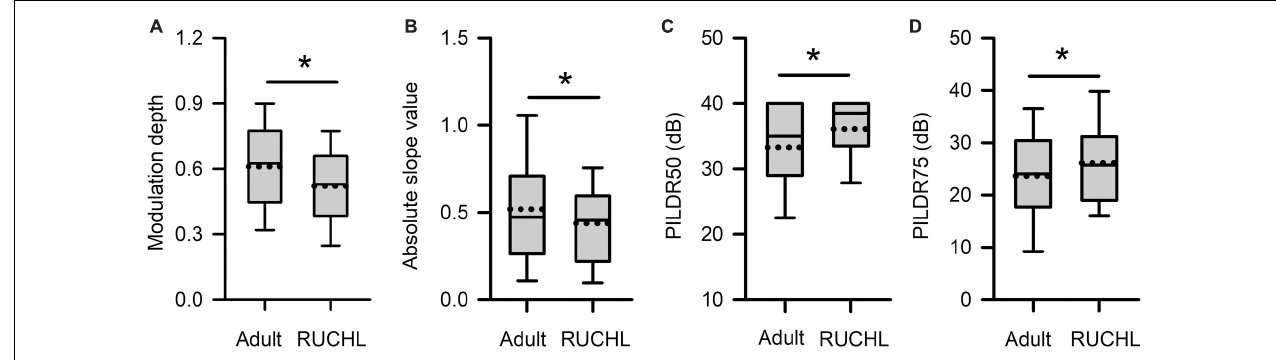
FIGURE 12 | Box plots showing the effects of RUCHL at young age on the sensitivity and the selectivity to ILDs of AI neurons in adulthood. (A) Modulation depth; (B) absolute slope value; (C) PILDR50; (D) PILDR75. The data for the PILDR50 the PILDR75 were determined from the averaged ILD response functions across ABL. * indicates significant difference between two groups (Mann–Whitney U -test, p < 0.05).